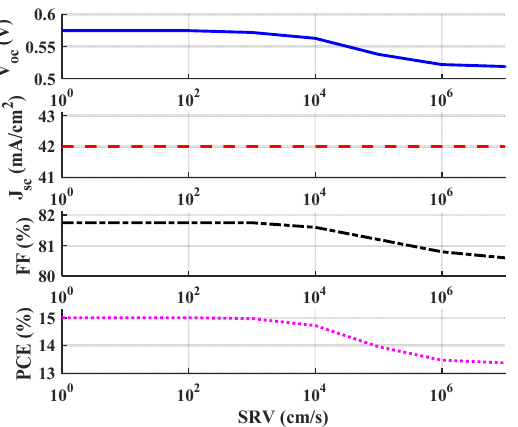
Figure 5. Photovoltaic parameter variation vs. surface recombination velocity.